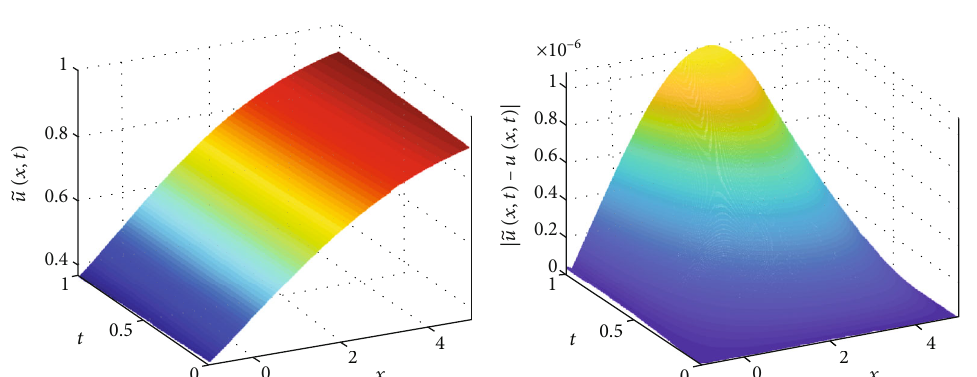
Figure 5: The exact solution (left) and the absolute error (right) of Example 3 with Δ t = 0 : 001 and h = 0 : 01 , without